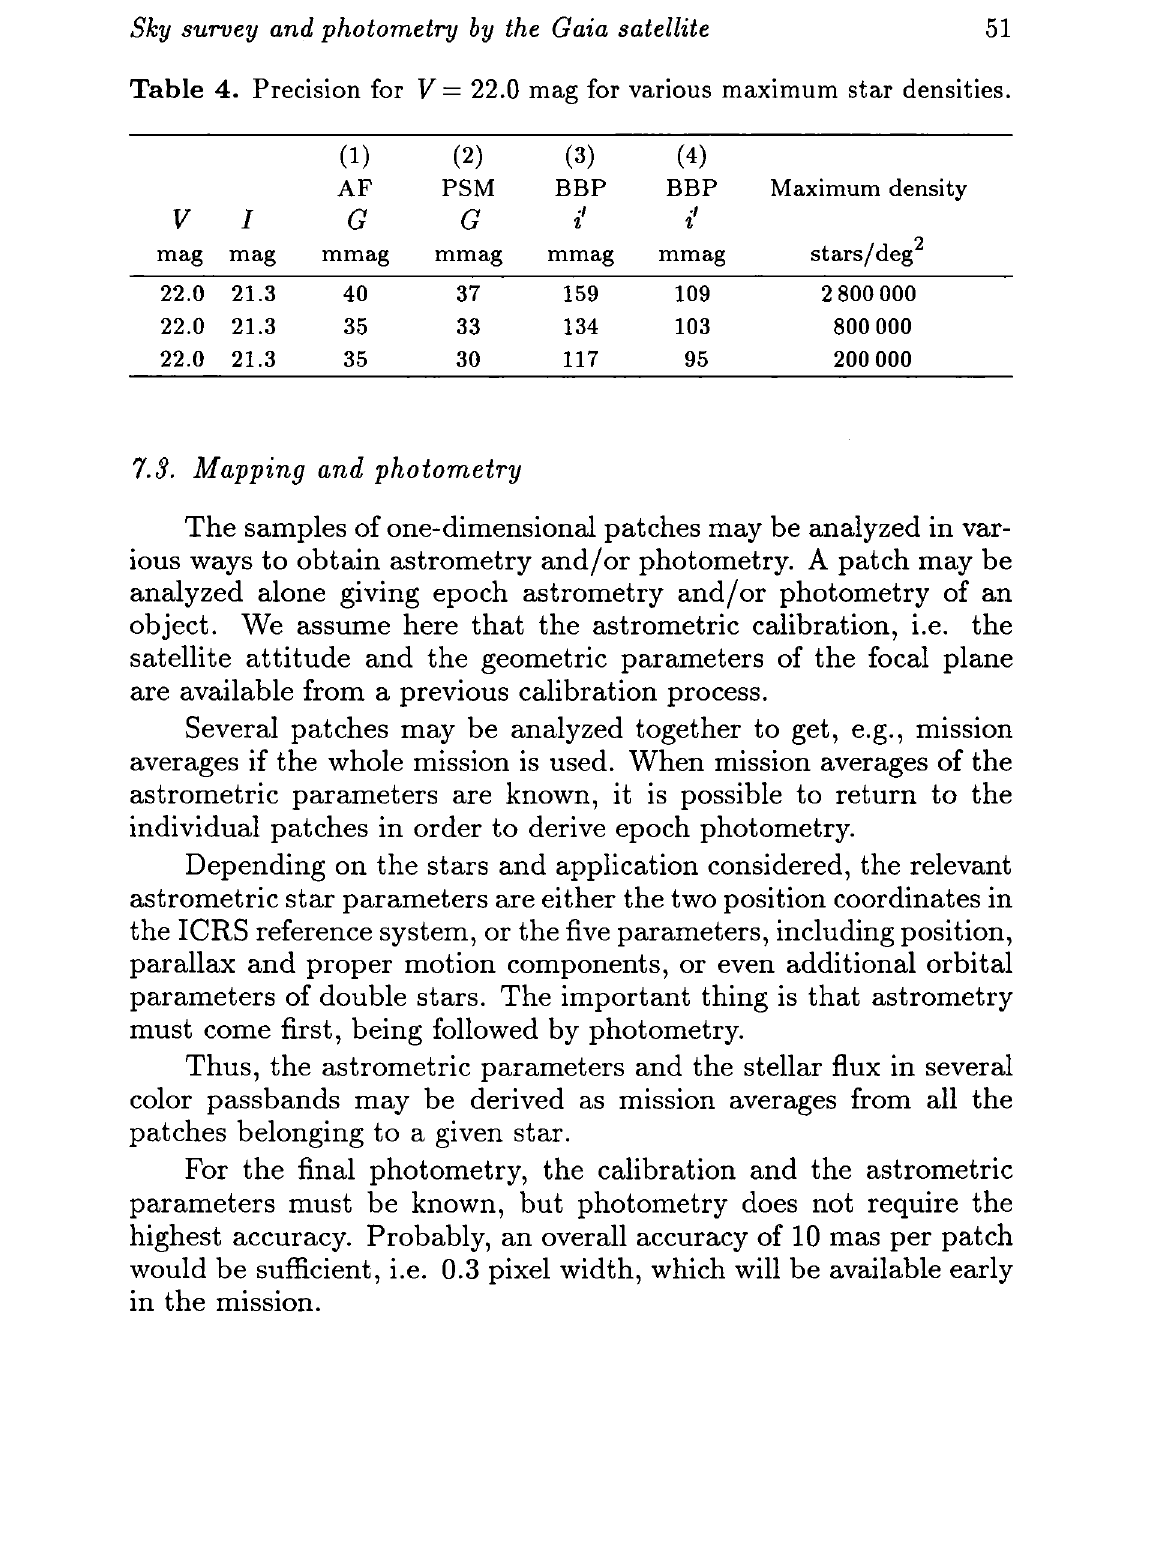
Table 4. Precision for V = 22.0 mag for various maximum star